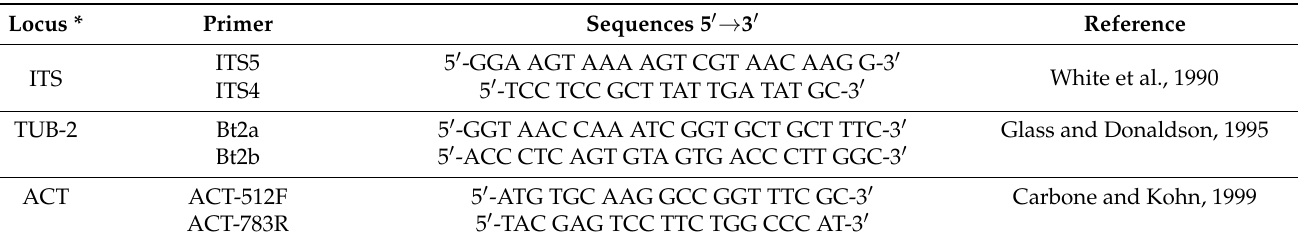
Table 2. Details of primers pairs used in this study for the amplification and sequencing of fungal